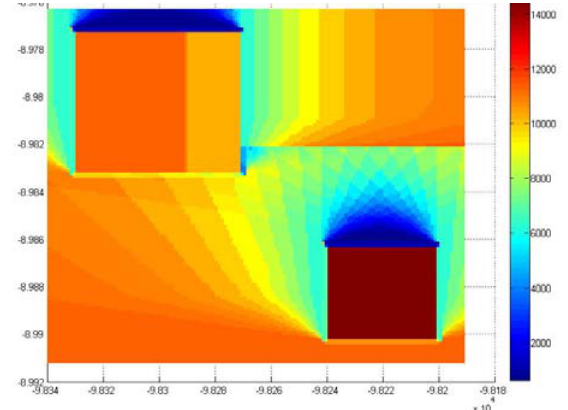
Figure 7. Radiation map without façades for January, the 31 th based on LiDAR data [Wh/m 2 ].